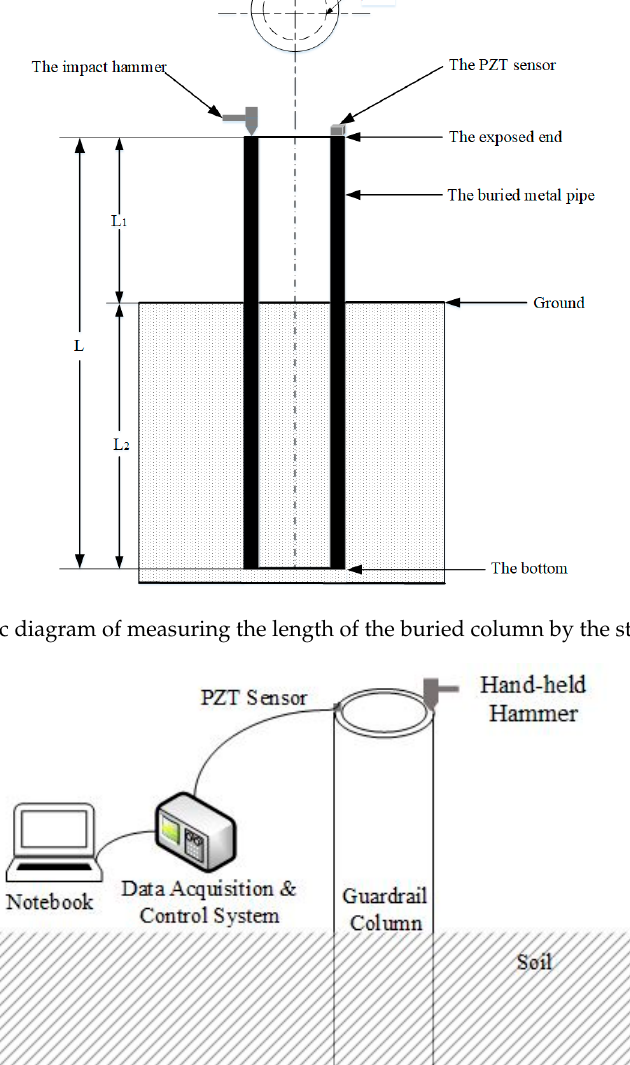
Figure 2. Schematic diagram of measuring the length of the buried column by the stress wave method.